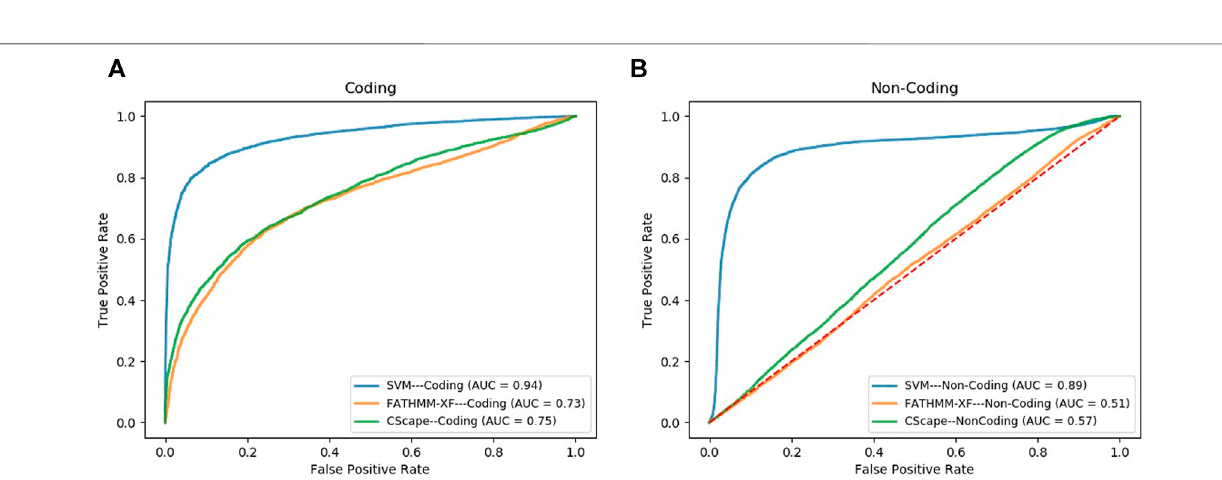
Frontiers in Genetics |